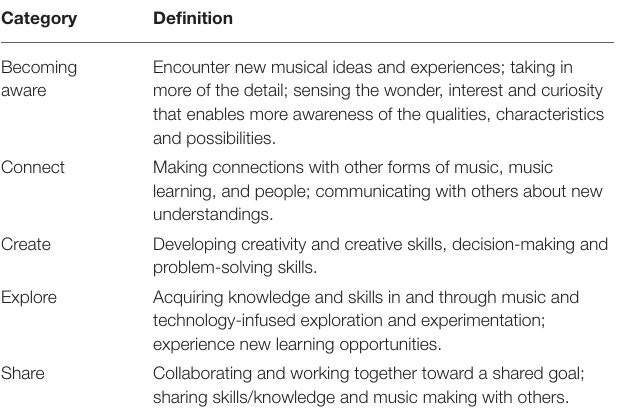
TABLE 5 | O’Neill (2016) categorization